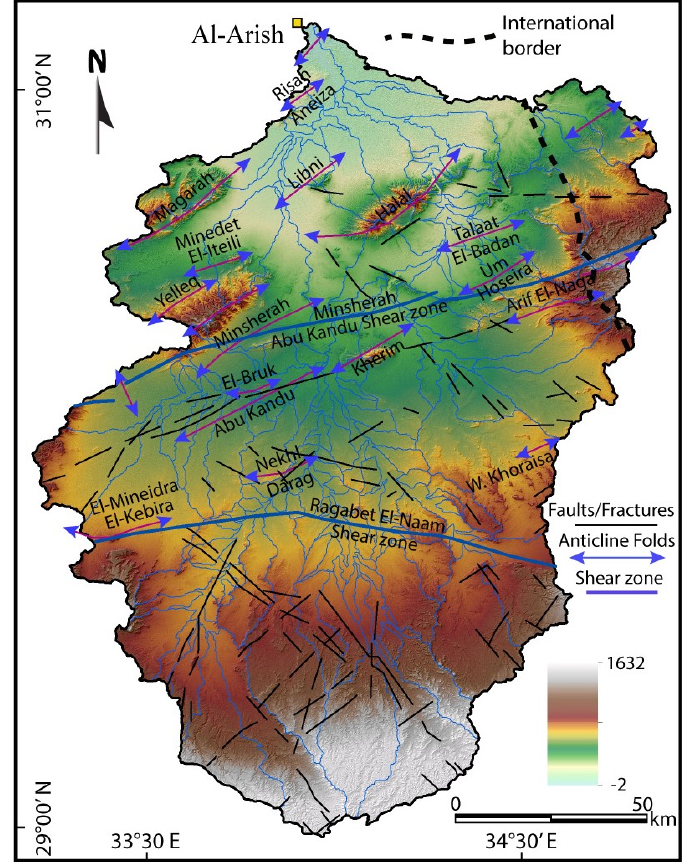
Figure 4. Shaded relief image (data from SRTM-30 resolution) of Wadi Al-Arish showing fractures, folds, and shear zones; modified after [18]. Blue hollow polygons indicate the classified catchments/sub-catchments of the study area.